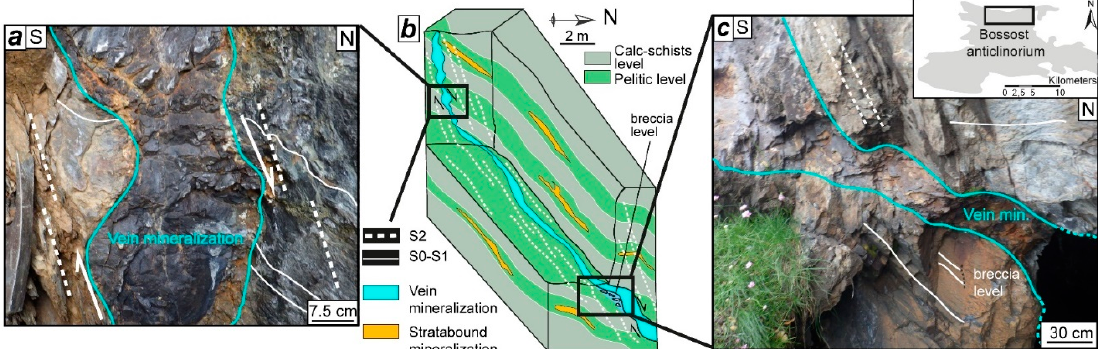
Figure 6. Field observations and 3D structural model of Pale Bidau deposit (see location in Figure 2a). ( a ) Vein Pb-Zn mineralization that occurs in pull-apart geometry; ( b ) 3D model presenting the relations between stratabound and vein Pb-Zn mineralizations; and ( c ) vein mineralization with presence of breccia at the base of a pull-apart mineralized structure.